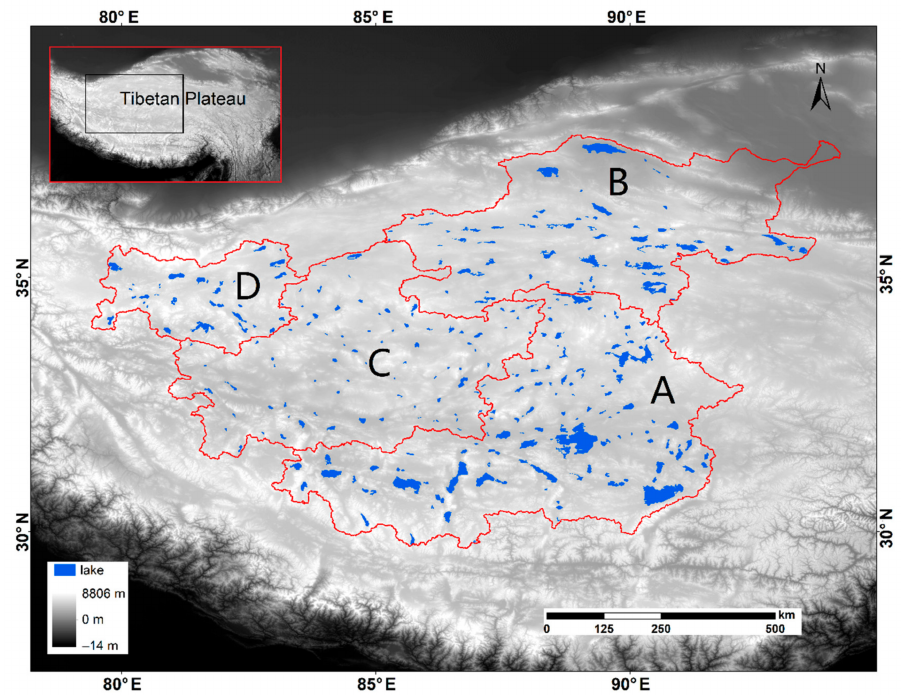
Figure 1. Location of the study area and distribution of lakes in the inner Tibetan Plateau. A, southeastern part; B, northeastern part; C, the inner part of study region; D, northwestern